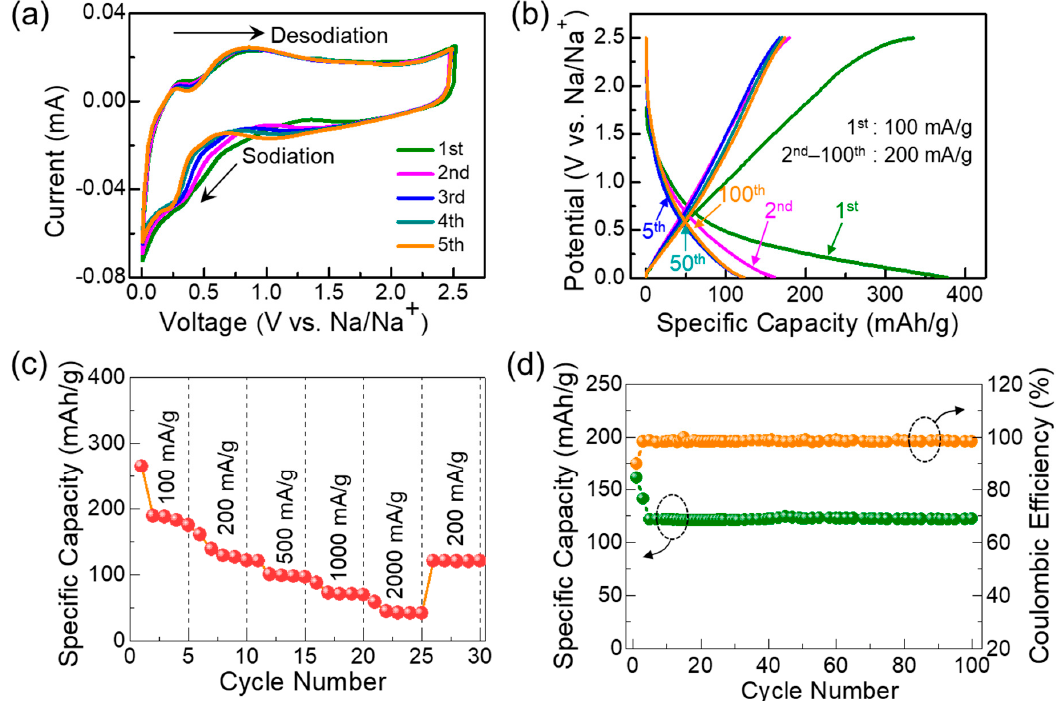
Figure 5. Electrochemical SIB anode performances of the C-Si nanocomposites: ( a ) CV curves measured at r s = 0.2 mV/s, ( b ) GCD profiles measured under the current injection of 100–200 mA/g, ( c ) Rate performances at various current injection conditions, and ( d ) Coulombic efficiency and cyclic stability measured under the current injection of 200 mA/g.